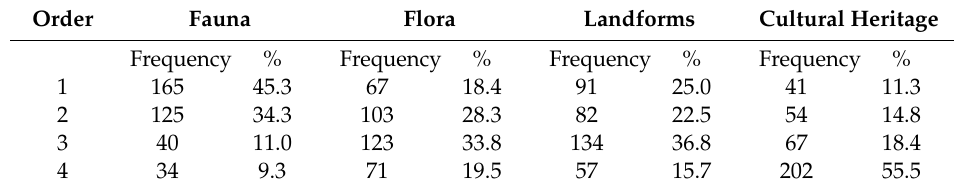
Table 3. Preferential ordering in responses to questions CP1 (Section CP, question 1) and CP2 (Section CP, question 2).